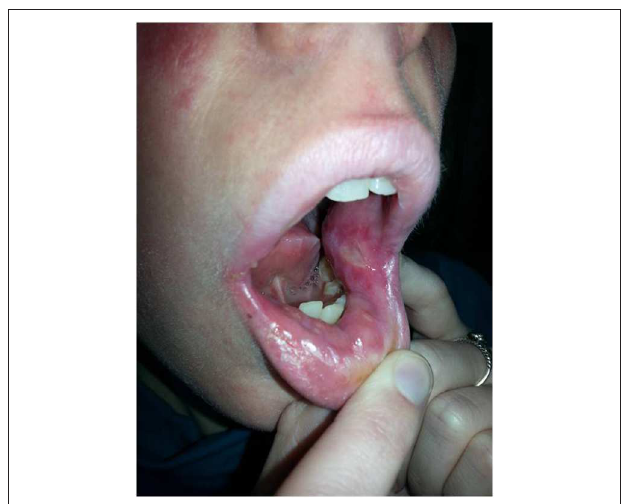
FIGURE 1 | Painful, deep ulcer in the left buccal mucosa at age